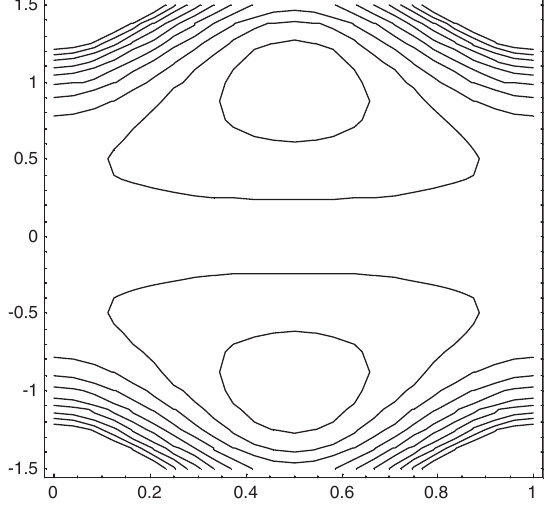
Fig. 14. Streamlines in the wave frame when Q =0.9, φ =0.6, M =0.001, N =0.25.